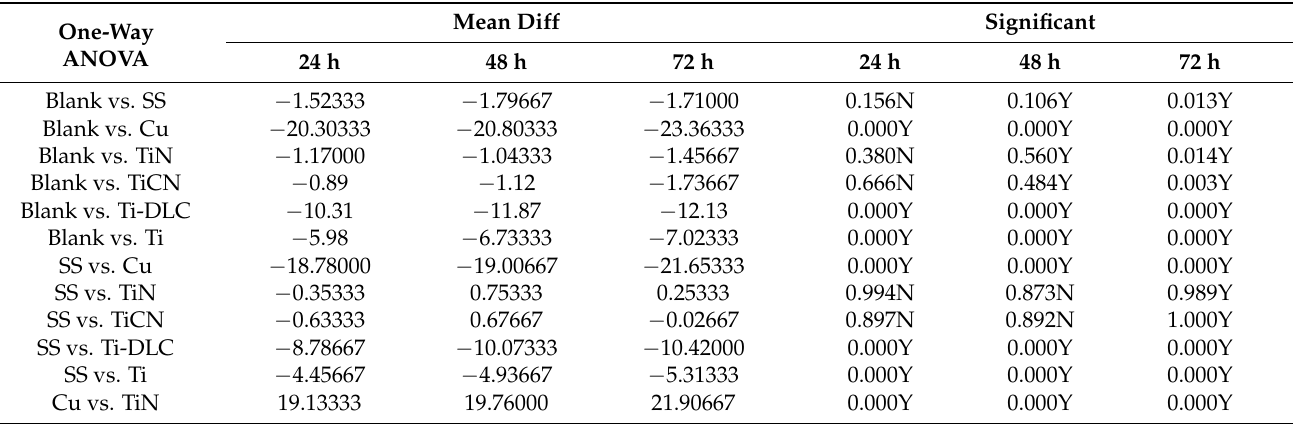
Table 2. Flow cytometry test